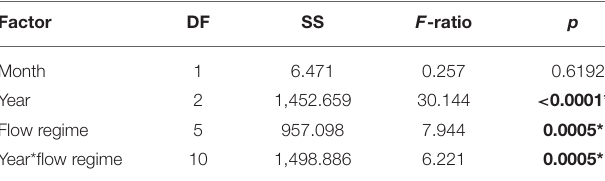
TABLE 3 | Three-way ANOVA output of coral mortality by survey month (December and October surveys), bleaching event year (1996, 2014, and 2015), flow regime (as defined by Lowe et al., 2009), and the interaction of flow and